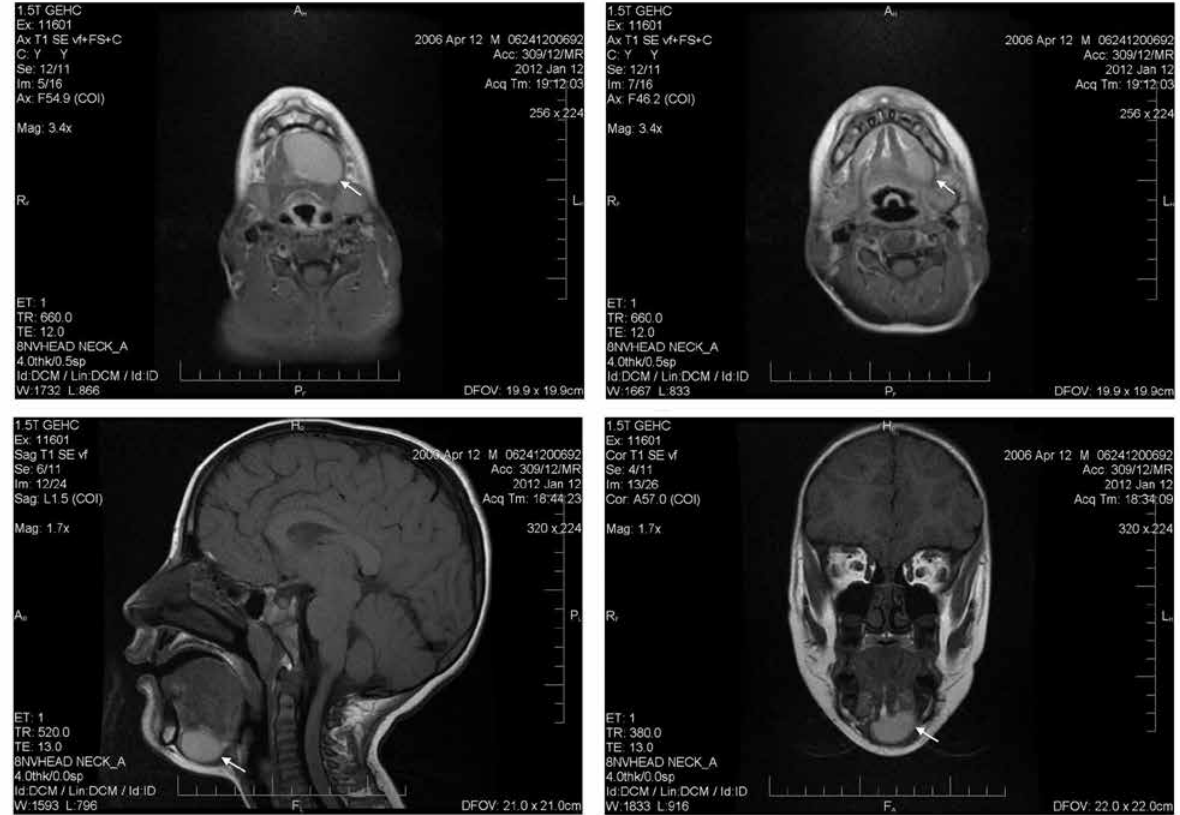
Figure 1: A 6-year old boy. MR image of the head. The arrow points a cystoid lesion in the left submental